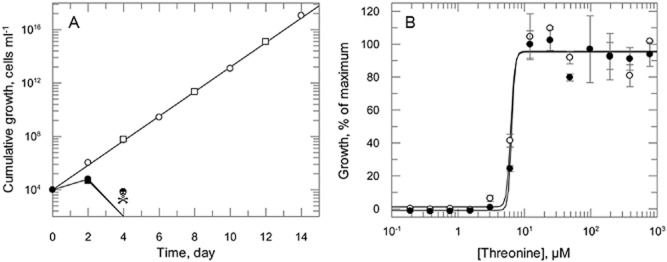
Growth analyses of bloodstream WT and DKO cells in vitro.A. WT (circles) and DKO (squares) cells cultured in TBMTD with (open symbols) or without (closed symbols) 800 μM threonine. No viable cells visible after 4 days ().B. Growth of WT (open circles) and DKO (closed circles) cells in varying concentrations of L-threonine.